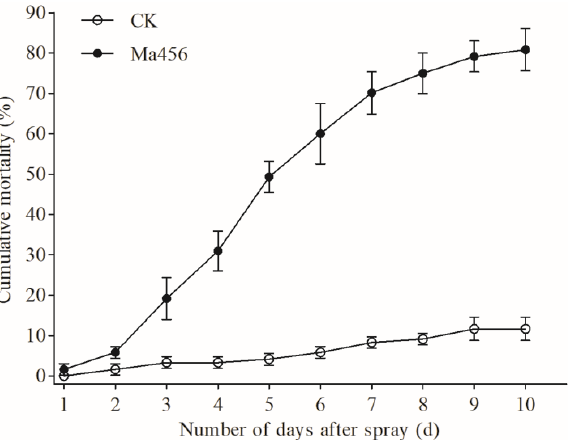
Figure 1. Cumulative mortality rate of BPH fifth-instar nymphs infected by Ma456. Error bars: SD of the mean from three replicates.